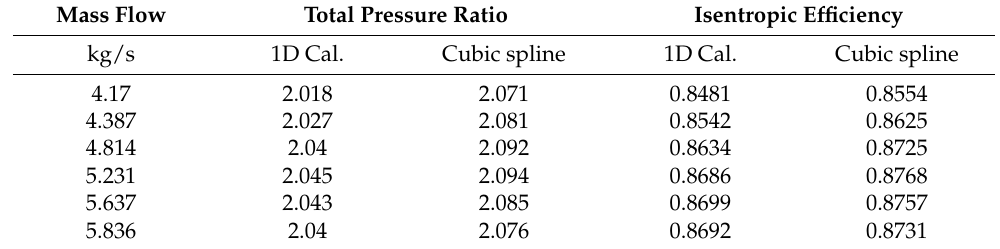
Figure 9. Eckardt-O performance comparison: ( a ) Total pressure ratio comparison; ( b ) Efficiency comparison. Table 3. Comparison of one-dimensional prediction and fit function results.